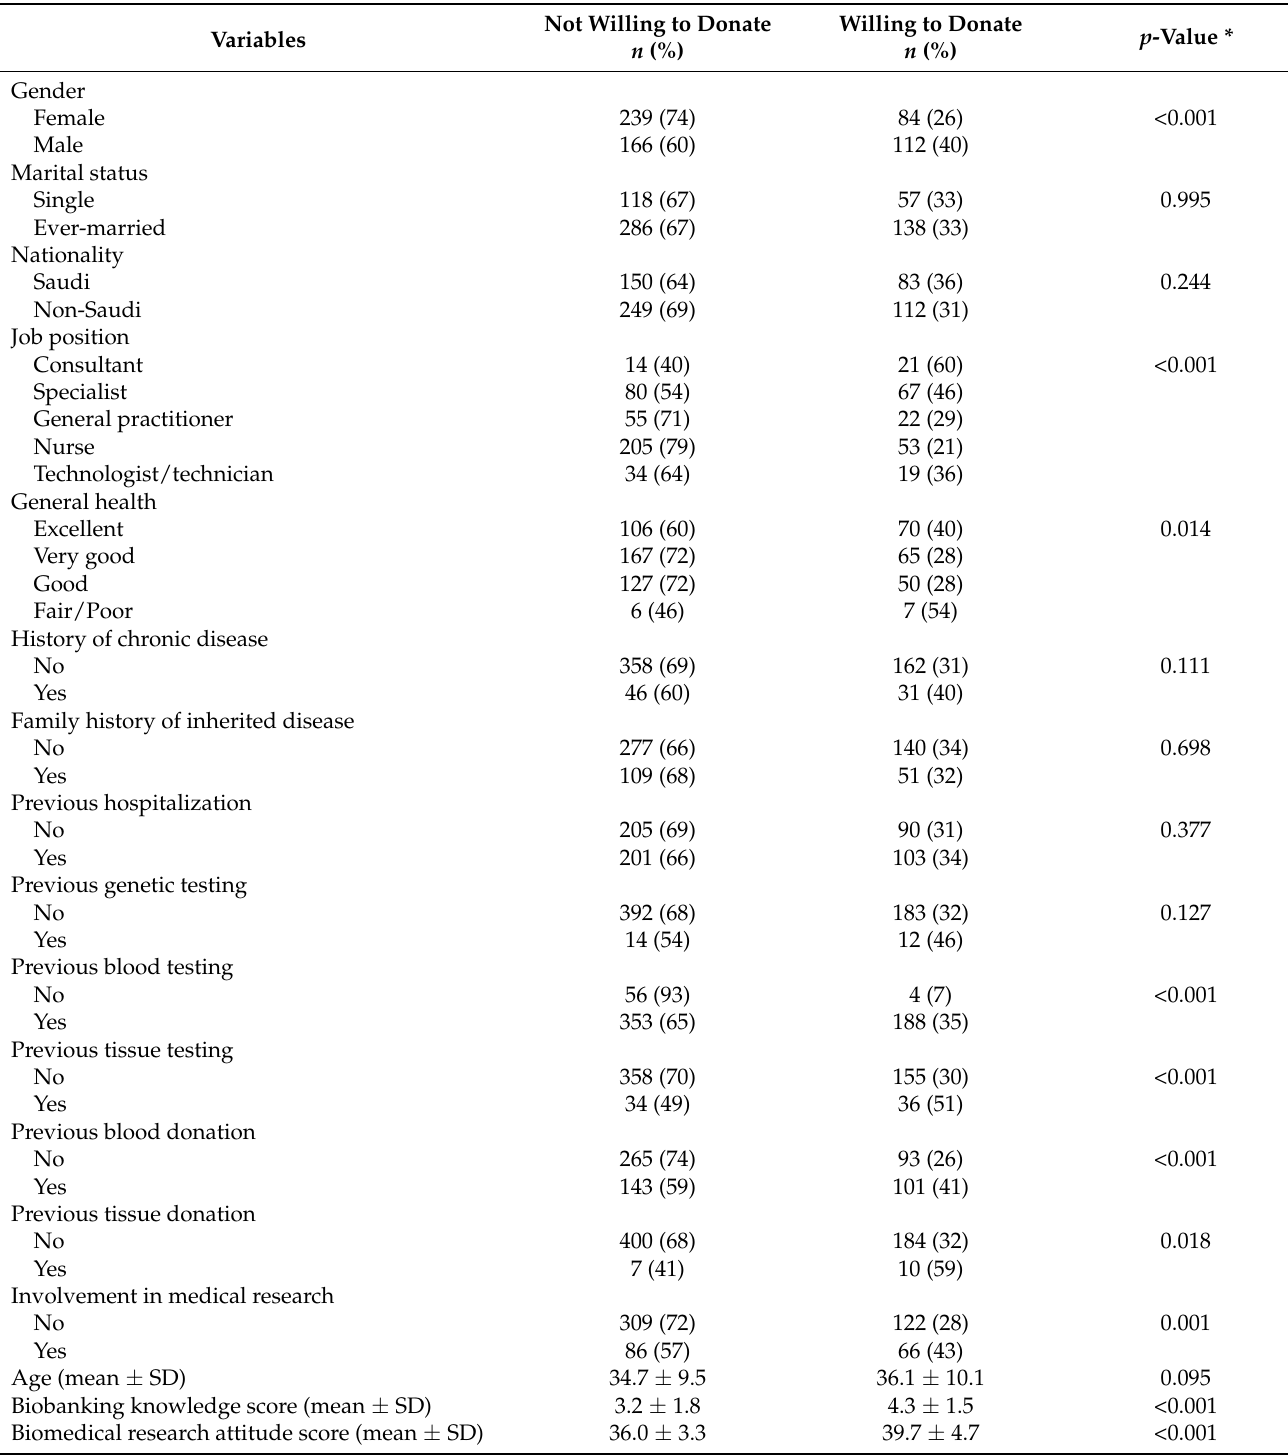
Table 4. The associations between sociodemographic, health-related, and biobanking-related vari- ables and willingness to donate